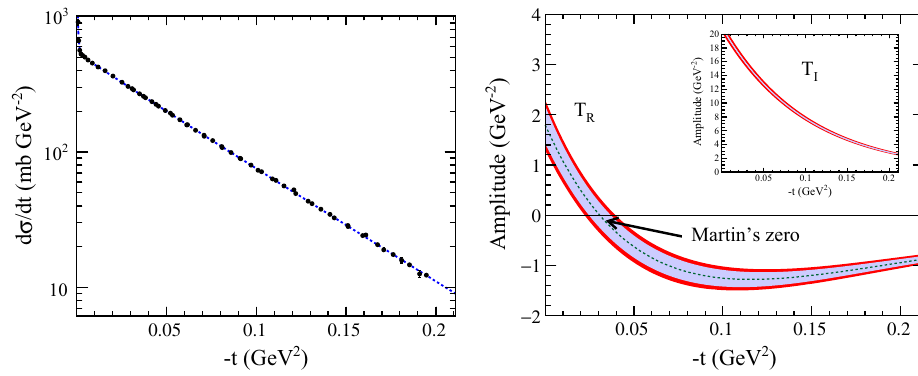
Fig. 1 Result of the T8 data d σ/ d t fit (left) and the corresponding real and imaginary amplitudes (right)